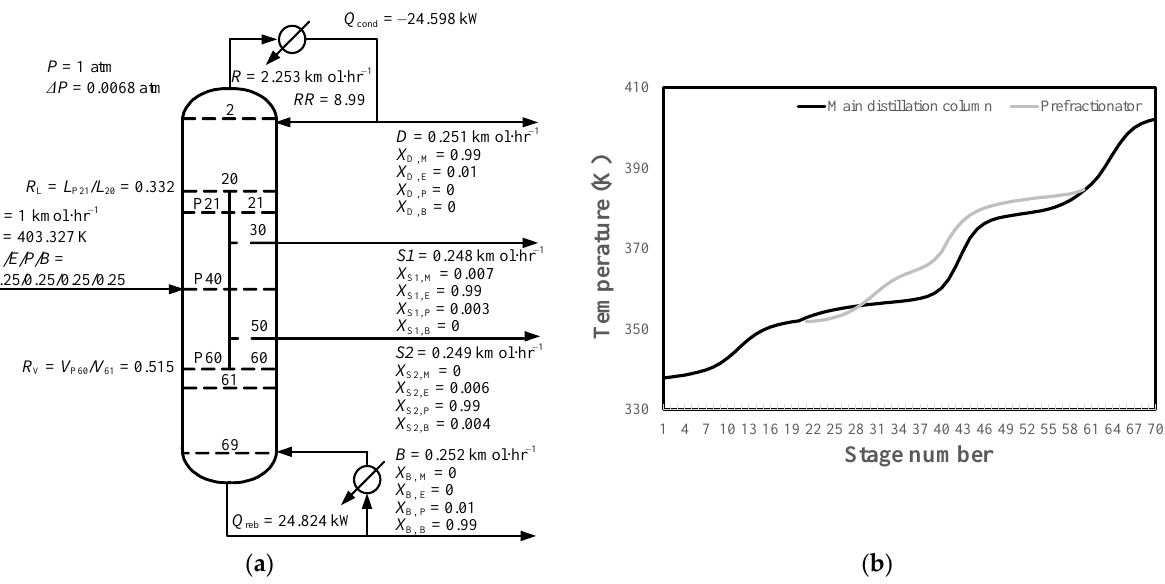
Figure 8. Example of the MEPB Kaibel DWDC: ( a ) steady-state design; ( b ) temperature profile.